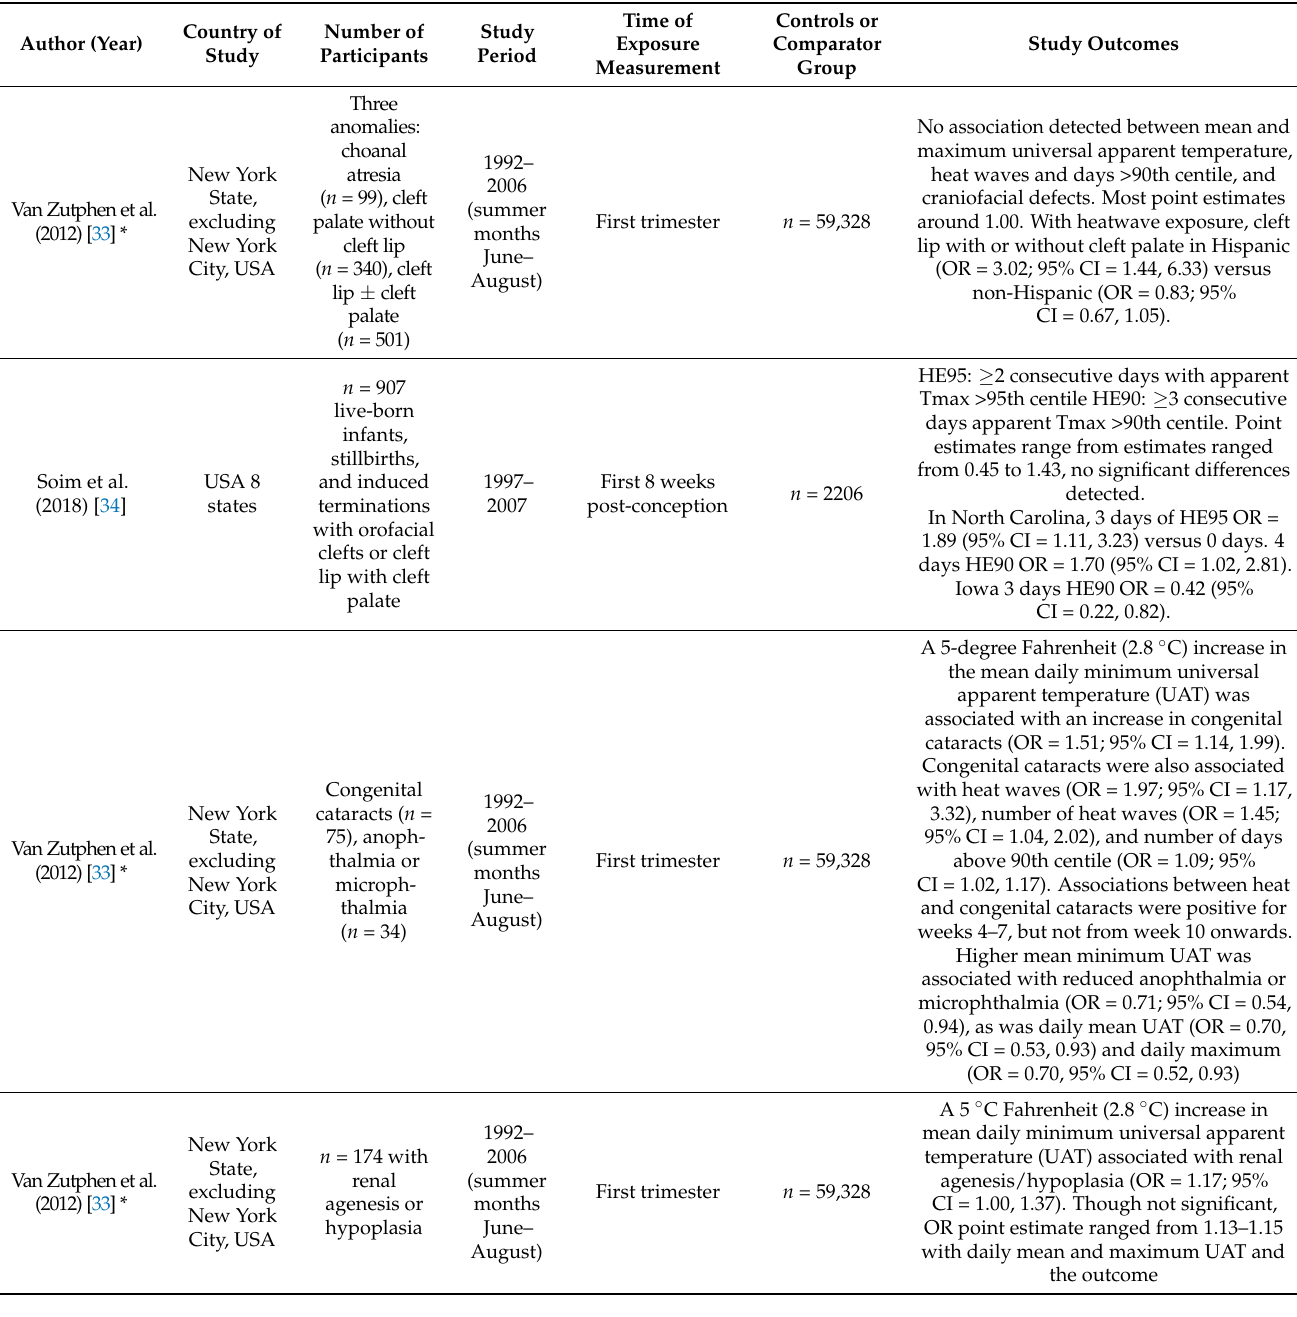
Table 3. Results of heat exposure and orofacial cleft or craniofacial, musculoskeletal, genitourinary, eye and lethal congenital